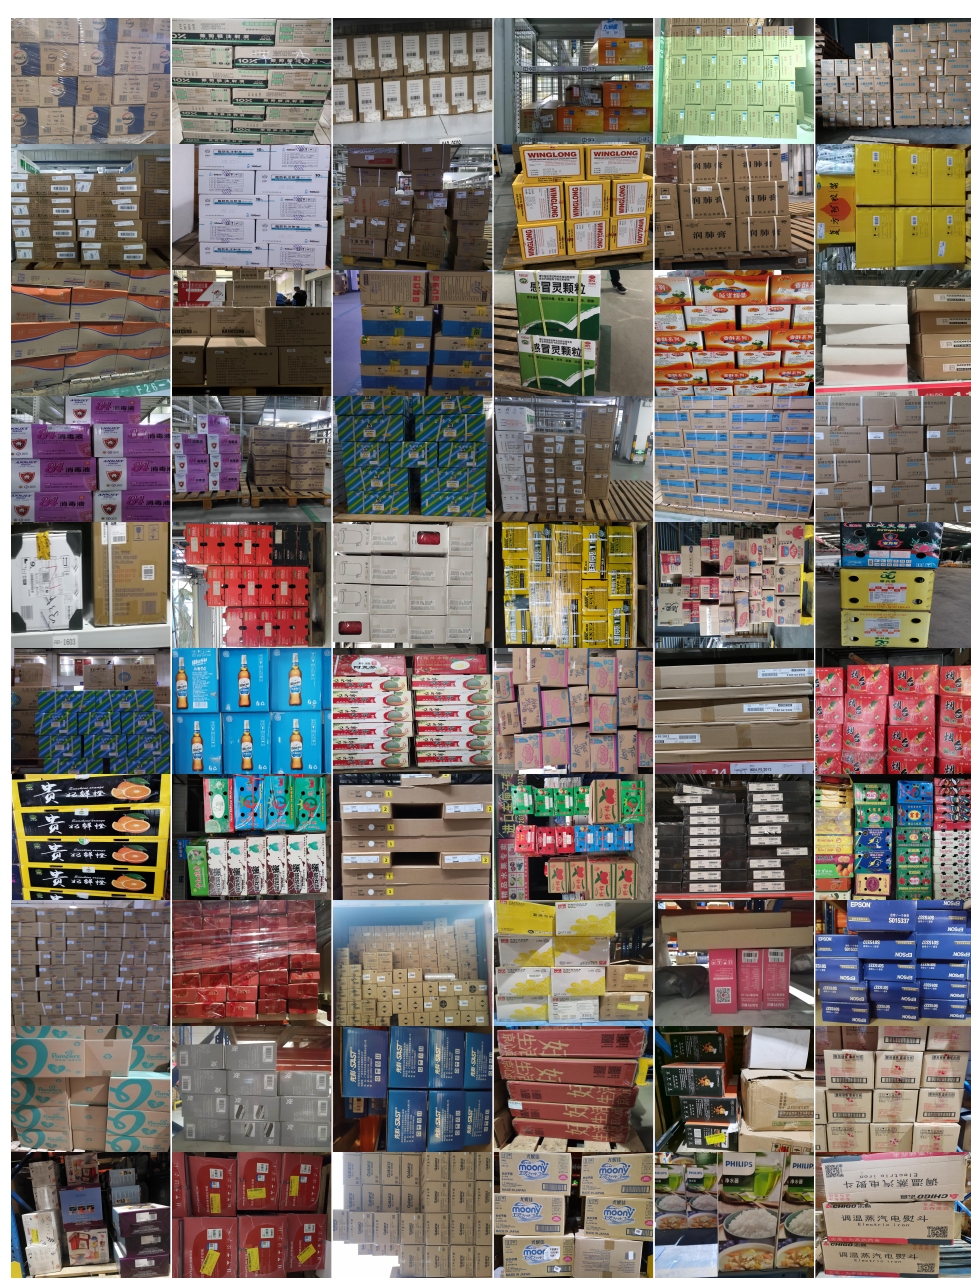
Figure A2. Randomly sampled images related to cartons on